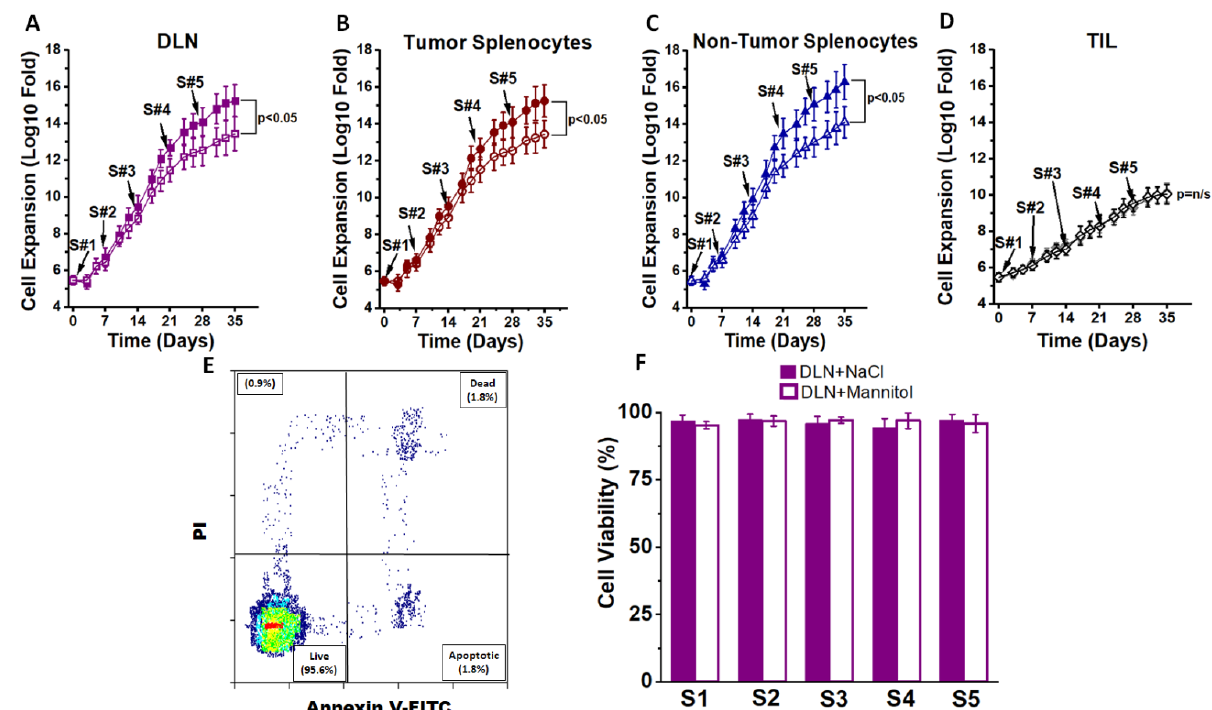
Figure 1. Ex vivo expansion of CD4+T cells. ( A ) The CD4+T cells obtained from draining lymph nodes (DLNs) of day 28 Py230-othrotopic syngeneic breast tumor bearing mice were expanded in the presence of high salt culture treatment (∆0.035 M NaCl, filled boxes) or with control equimolar mannitol (0.035 M mannitol, open boxes). CD4+T cells were subjected to five stimulation cycles (S1–S5), with each cycle lasting for 7 days and a total of 35 days. Stimulation cycle details including other chemicals used in the cell culture are provided in the “Materials and Methods” and “Results” sections. ( B ) The CD4+T cells obtained from the spleens of day 28 tumor bearing mice were expanded in the presence of high salt culture treatment (filled circles) or with control equimolar mannitol (open circles). ( C ) The CD4+T cells obtained from the spleens of 12-week-old non-tumor bearing mice were expanded in the presence of high salt culture treatment (filled triangles) or with control equimolar mannitol (open triangles). ( D ) CD4+Tumor infiltrating lymphocytes (TILs) were isolated by magnetic bead separation and stimulated for 5 cycles with either high salt (filled grey diamond) or mannitol (open diamond). ( E ) Cell viability test for staining with propidium iodide and annexin V staining. ( F ) Cell viability reported at the end of each 7 day stimulation cycle on CD4+T cells obtained from DLNs. A similar >95% viability was noted on CD4+T cells obtained from tumor splenocytes, non-tumor splenocytes and TILs. Further, no difference in viability was noted between salt treatment and mannitol treatment in any of the four cohorts mentioned above. Data presented as mean ± standard error of mean (SEM) from 5 independent CD4+T-cell expansions.